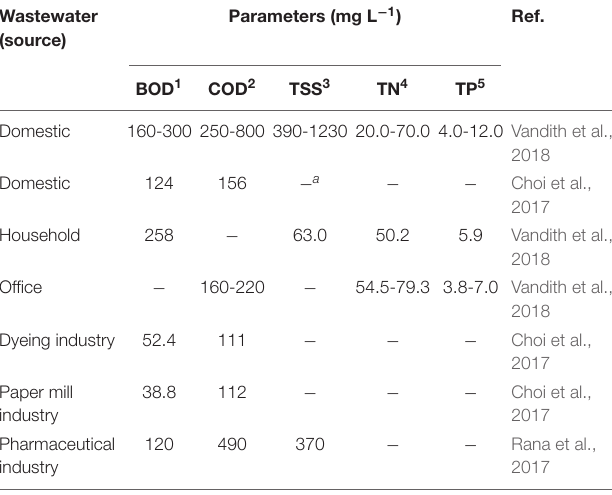
TABLE 1 | Comparison of characteristics of different wastewater